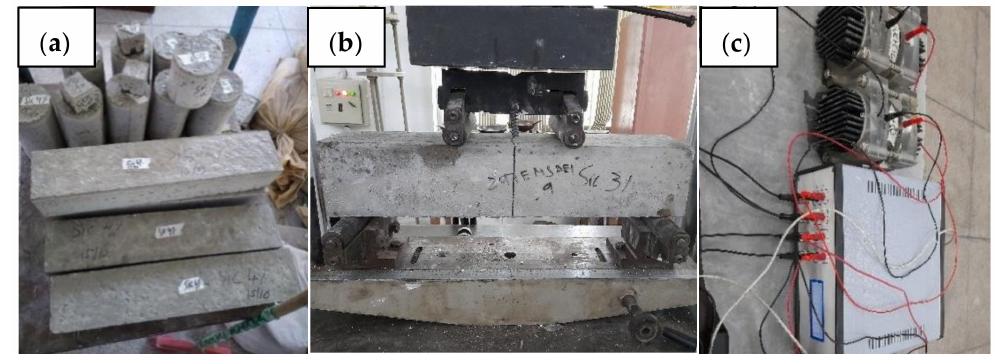
Figure 3. Experimental scheme ( a ) samples, ( b ) mechanical testing, ( c ) RCPT test